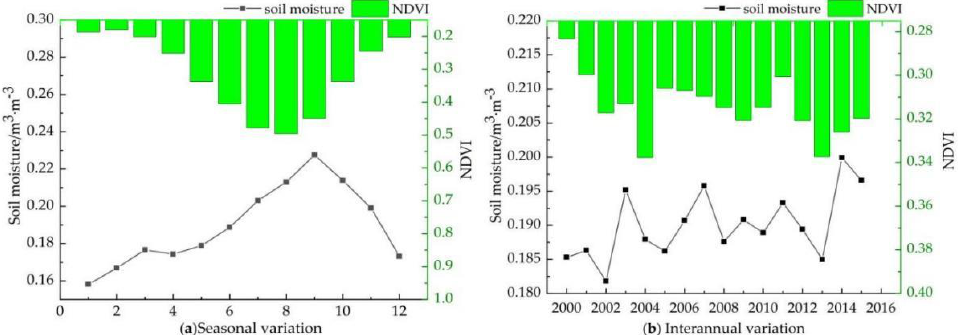
Figure 9. Seasonal and interannual variation of SM and NDVI in the Yellow River Basin, 2000 to 2015: ( a ) Seasonal variation, ( b ) Interannual variation.